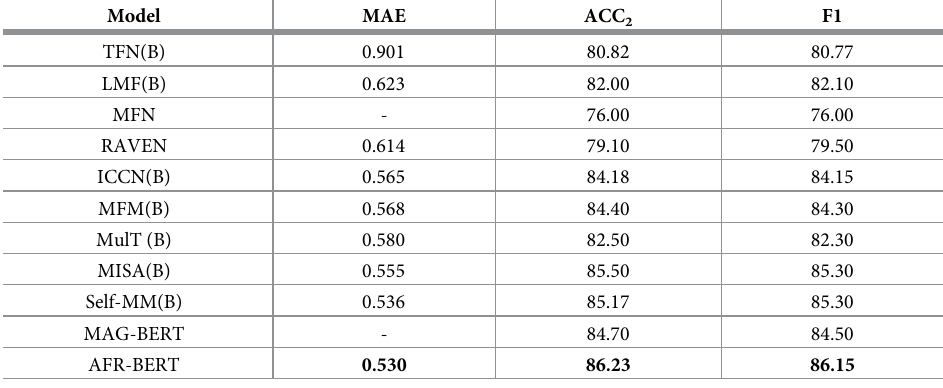
(B) means the language features are based on BERT. (-) means null value. The bolded values represent the best values of the performance